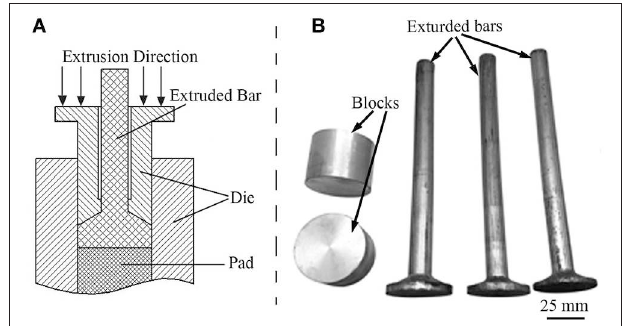
FIGURE 1 | (A) Schematic illustration of the extrusion; (B) Blocks and extruded bars.